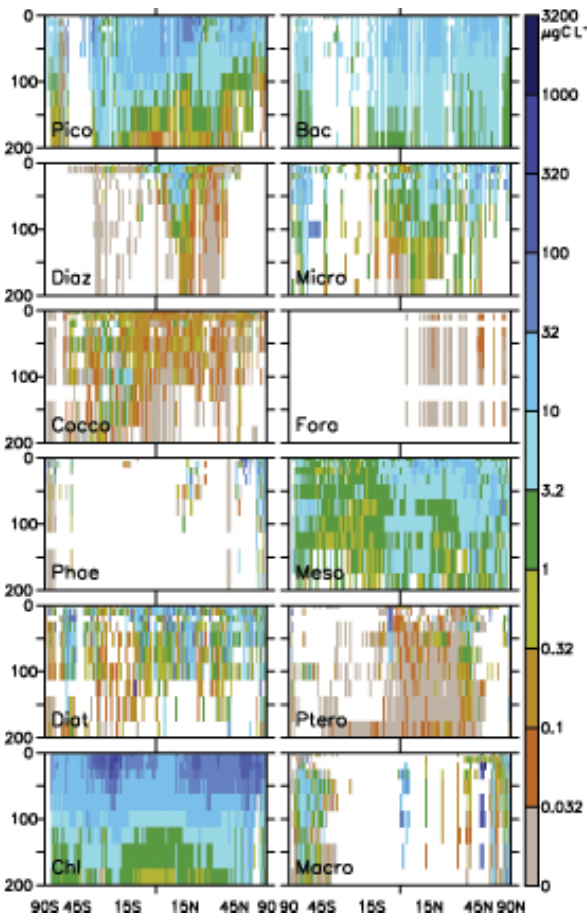
Figure 3. Zonal average PFT biomass [ µ gCL − 1 ]. (Pico) Picophy- toplankton, (Diaz) diazotrophs, (Cocco) coccolithophores, (Phae) Phaeocystis , (Diat) diatoms, (Chl) WOA 2005 chlorophyll × Plank- TOM5.3 C:Chl ratio, (Bac) picoheterotrophs, (Micro) microzoo- plankton, (Fora) foraminifers, (Meso) mesozooplankton, (Ptero) pteropods, and (Macro) macrozooplankton.